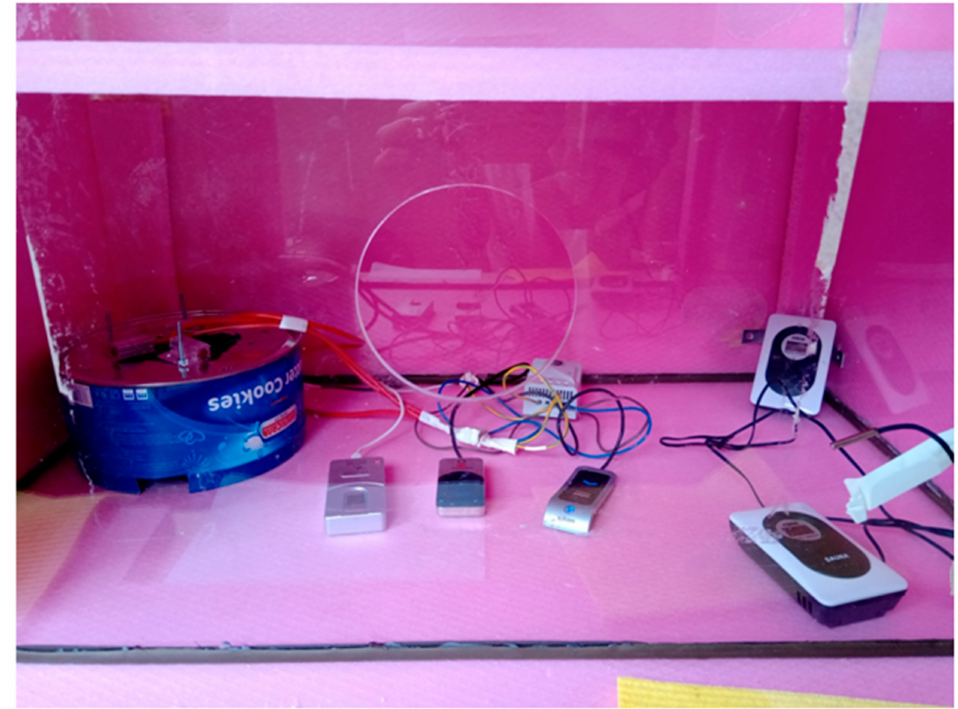
Figure 2. Fingerprint sensors and other equipment used for the third acquisition